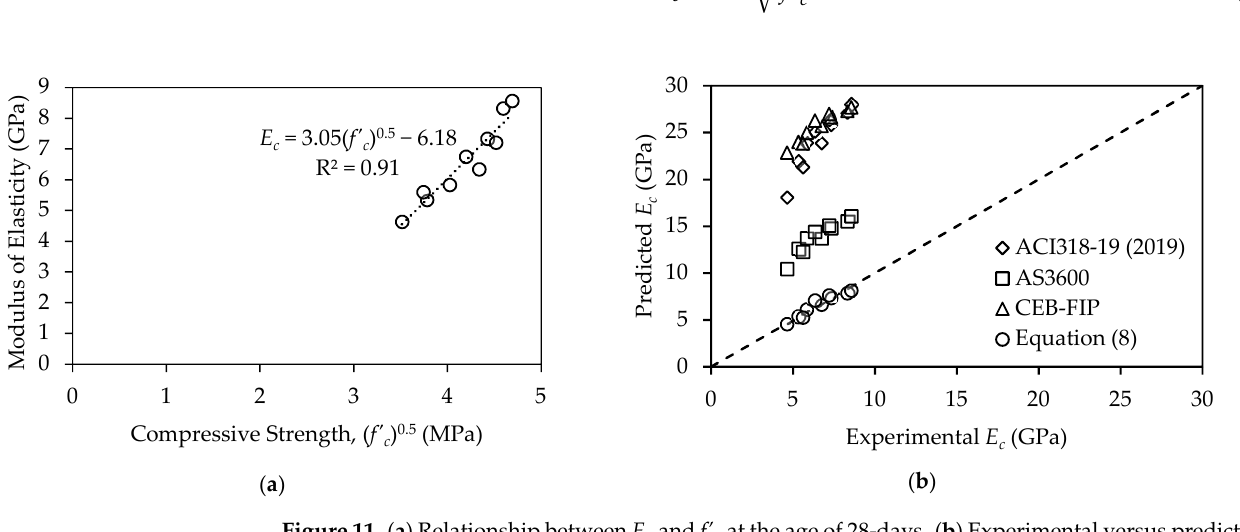
Figure 11. ( a ) Relationship between E c and f’ c at the age of 28-days. ( b ) Experimental versus predicted modulus of elasticity, E c .